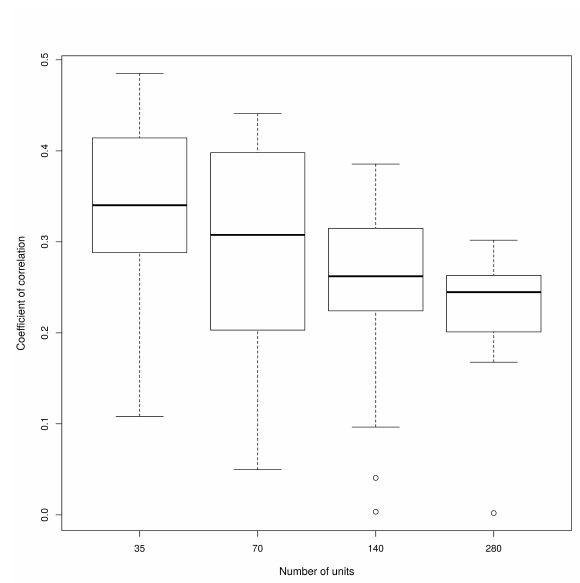
Figure 3: Variation of the Pearson coefficient between the defor- estation rate and the index of marginalisation due to change in the number of units (scale effect)